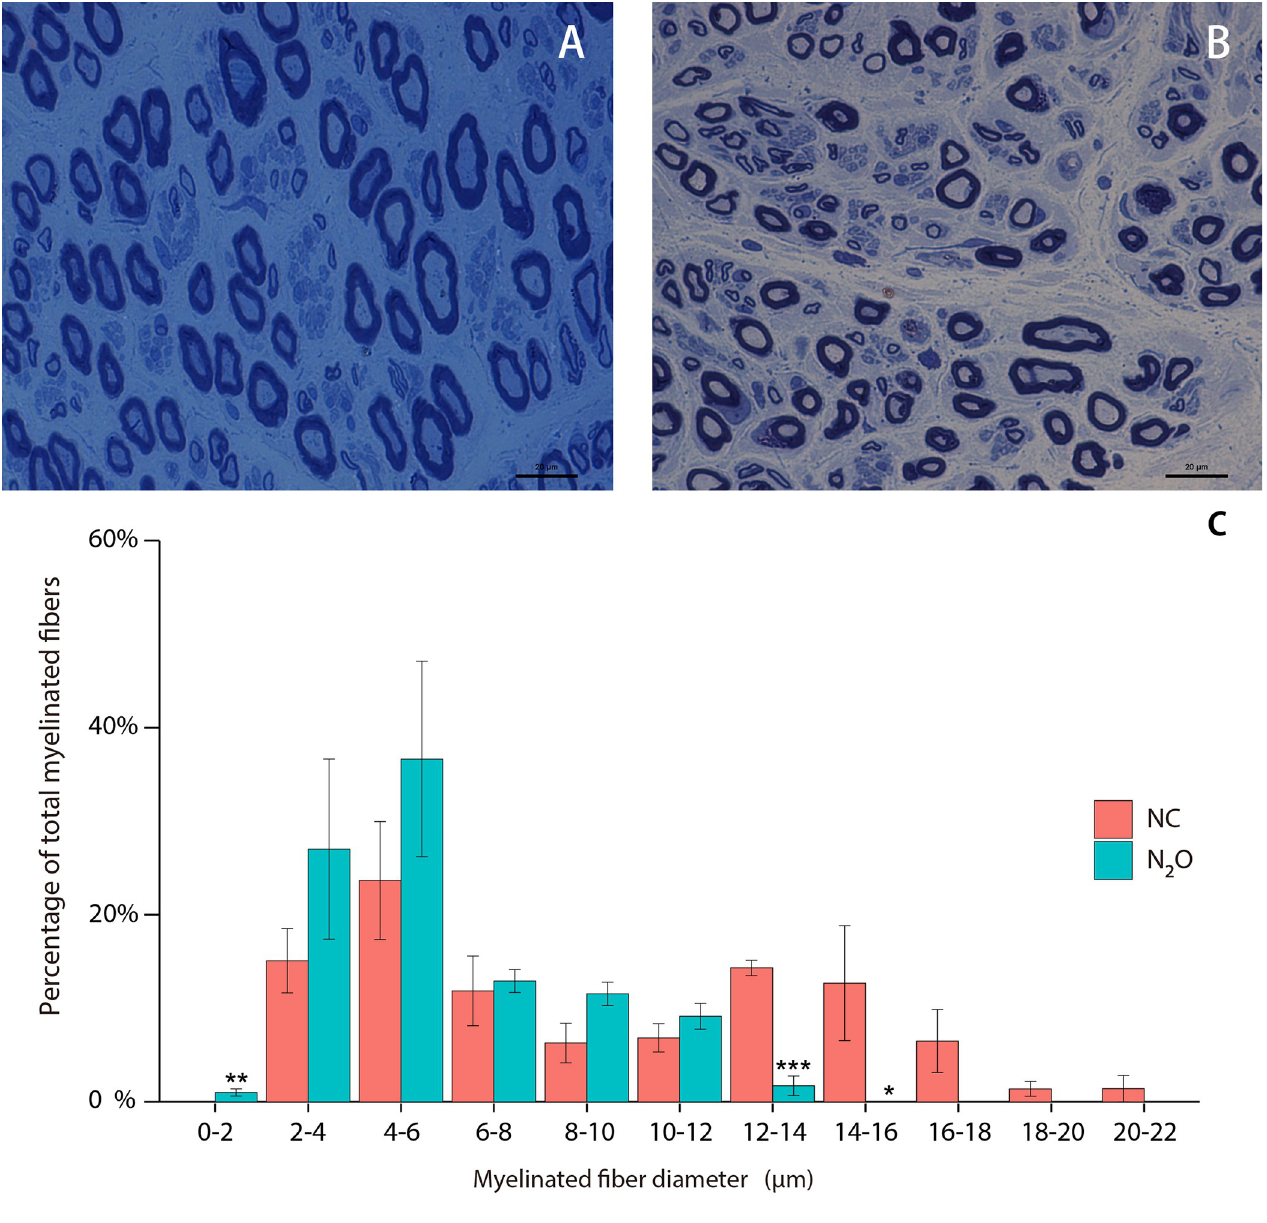
Fig 4. Semi-thin section toluidine blue staining of sural nerve. (A) Sural nerve biopsy showing normal large and small myelinated nerve fibers without pathological alterations. (B) Sural nerve biopsy of patients with N 2 O-induced peripheral neuropathy. (C) Distribution of myelinated fiber diameters is shown as a histogram with 1 μ m bin. Significant difference is indicated by ��� p < 0.001, �� p < 0.005, � P < 0.01.